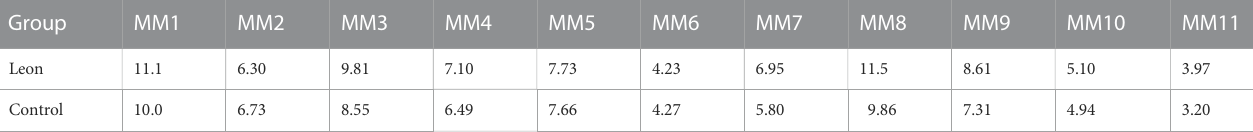
TABLE 9 The MFI of HLA-DR expression on moDCs (× 10 5 ) (MM patient-moDCs, n = 11).